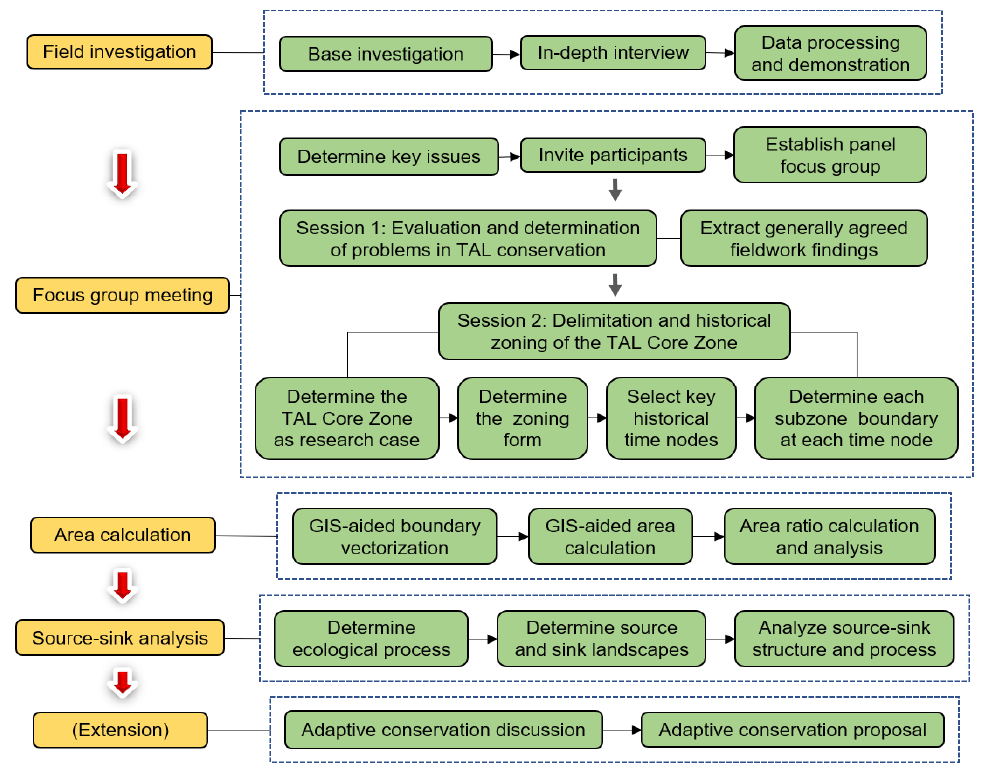
Figure 6. Methodological framework. The dotted line boxes represent the parts of the framework; the red, gray and black arrows indicate the direction of advancement of each part, each subpart and each specific operation step, respectively.